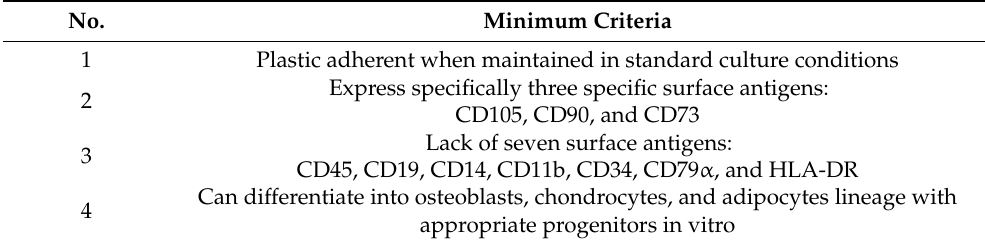
Table 1. Minimum Criteria for MSCs Based on The International Society for Cellular Therapy (ISCT)